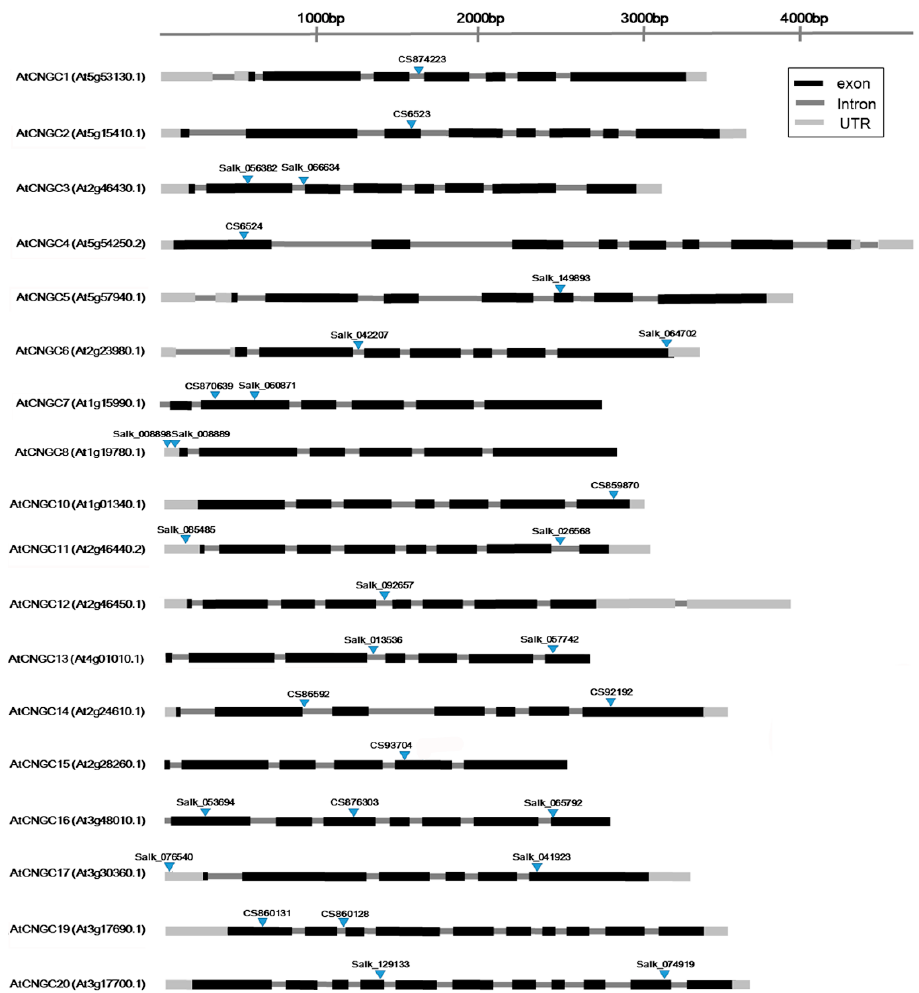
Figure 1. Schematic diagram illustrating the structure of the Arabidopsis CNGC family genes. The exon-intron structure in each of the genes is presented and the loci of the T-DNA insertions or single nucleotide substitutions (for AtCNGC2 , AtCNGC4 , AtCNGC14 and AtCNGC15 ) in the atcngc knockout mutants are marked with upside-down triangles. The Arabidopsis mutant seeds were obtained from the Arabidopsis Biological Resource Center (ABRC) (https://abrc.osu.edu/): Light grey: UTR, dark grey: intron, black: exon.